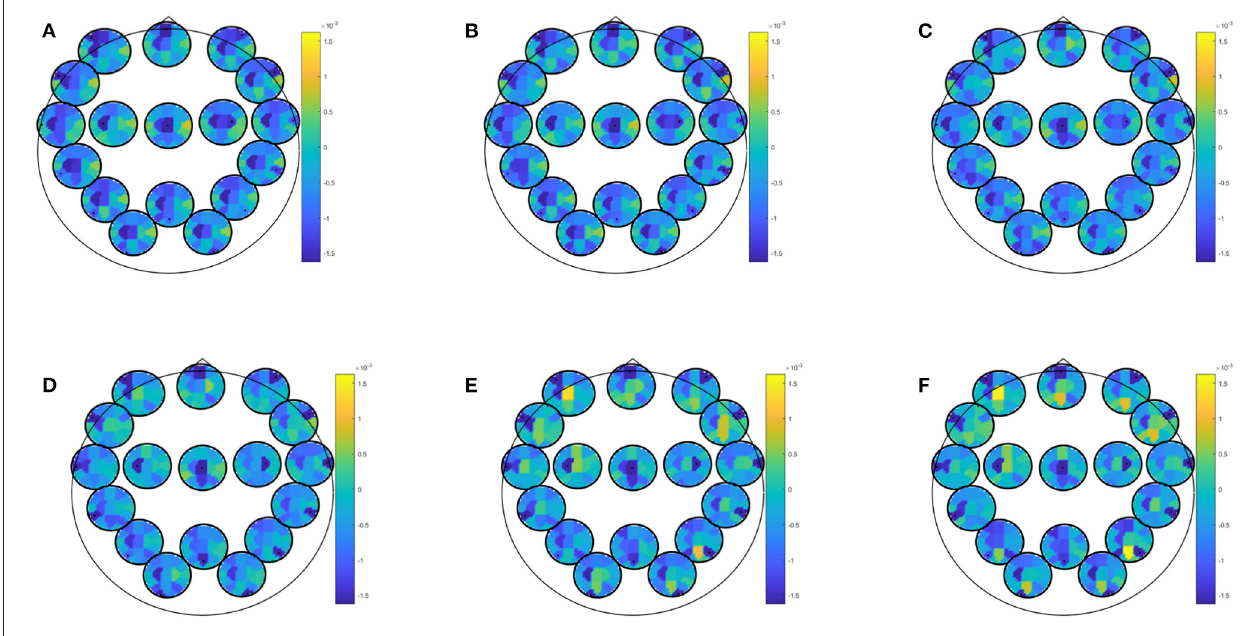
FIGURE 3 | Predictor coefficients β for questionnaire data combined with directed transfer function (DTF) extracted during rest with eyes open. Coefficients indicate importance of the feature to the model for prediction of at least mild depressive symptoms in winter. (A) Delta 1–4 Hz, (B) Theta 5–7 Hz, (C) Alpha 8–12 Hz, (D) Beta 13–20 Hz, (E) Beta 2 21–30 Hz, (F) Gamma 31–48